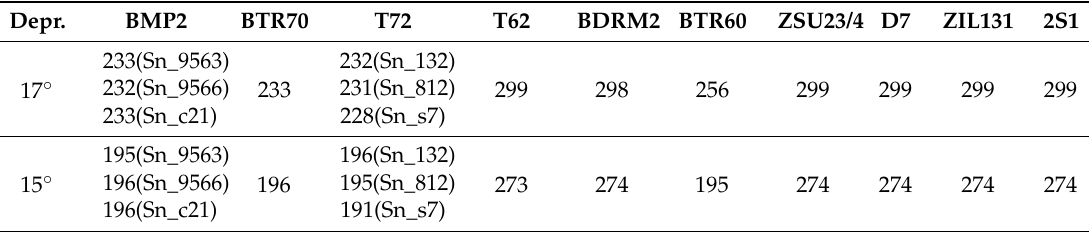
Table 1. Training and test sets in the experiments.